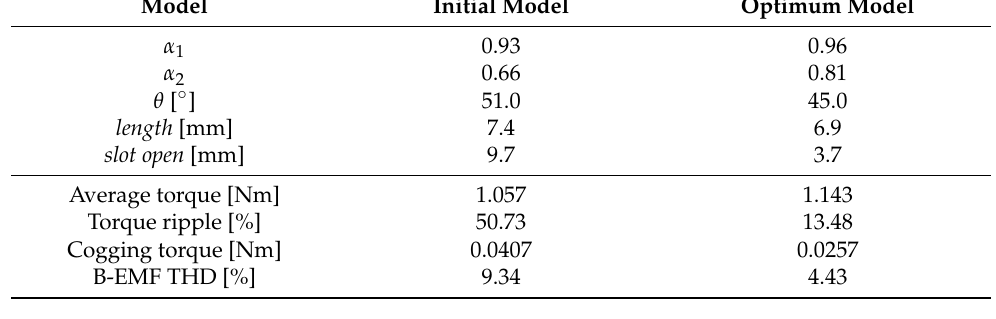
Table 4. Optimization result and performance comparison of the initial model and optimum model.